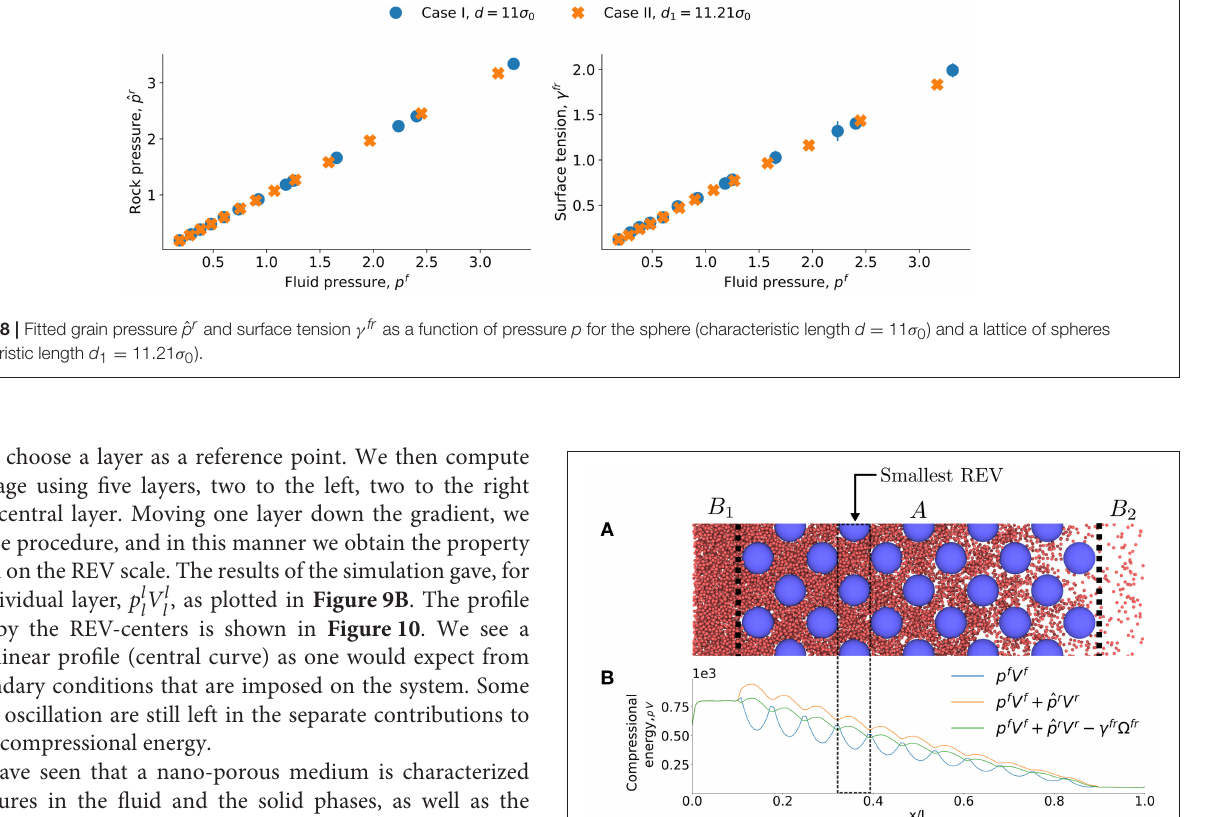
p r and surface tension γ fr as a function of pressure p for the lattice of spheres (characteristic length d 1 ˆ